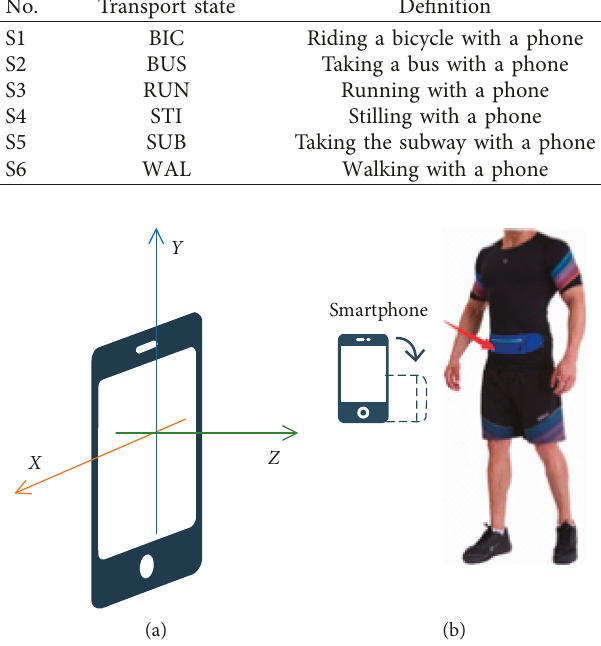
Figure 2: Wearing a phone on the waist. (a) Cell phone coordinate system; (b) how to put the smartphone.